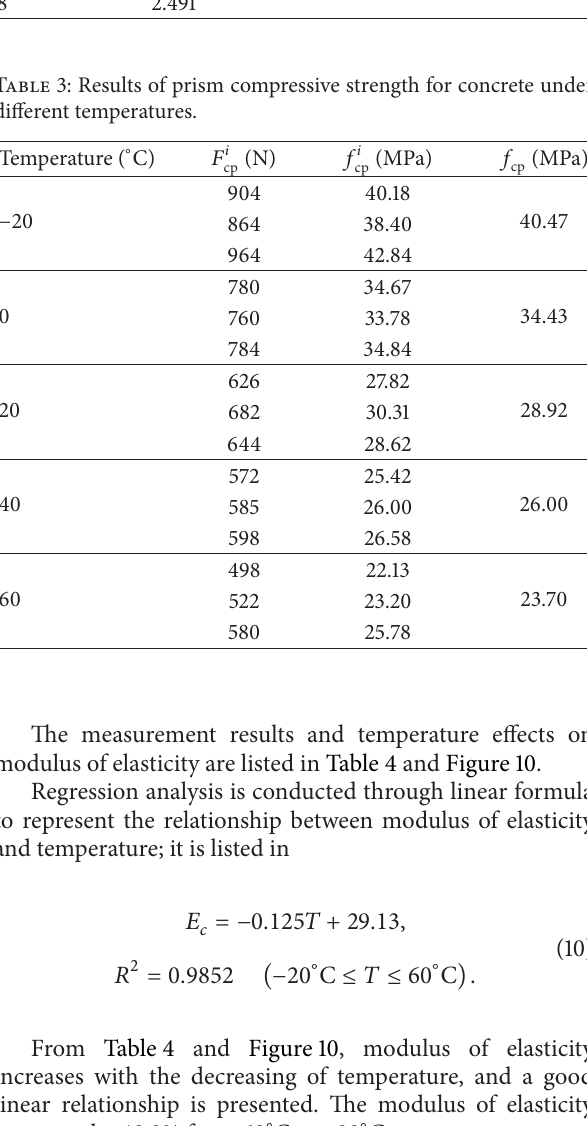
linear character. The prism strength decreases by 70.76% from − 20 ∘ C to 60 ∘ C.